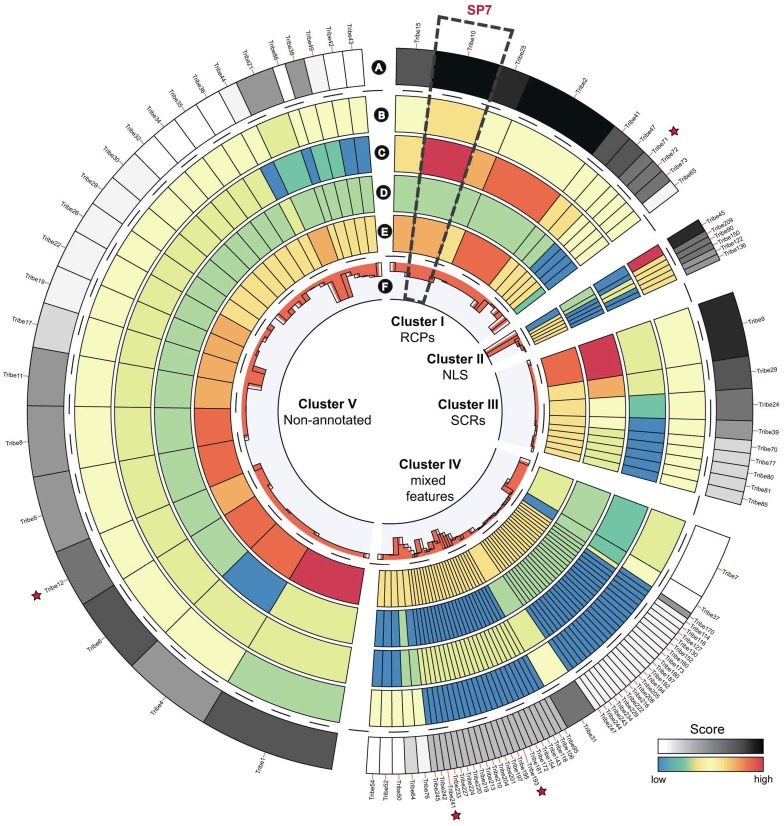
Top 100 ranked protein tribes containing putative effector candidates.Clusters were determined using hierarchical clustering of the top 100 ranked tribes containing putative effector candidates. A. Rank associated with each tribe based on their content of effector features. B. Score for number of members containing a nuclear localization signals (NLS). C. Score for number of members classified as repeat containing (RCPs). D. Score reflecting number of members classified as small and cysteine rich (SCRs). E. Score for number of members not annotated by searches against swissprot. F. Average protein sequence length for tribe members (ranging from 55 to 856 amino acids). Stars indicate tribes that contain members with similarity to the characterised effector SP7.